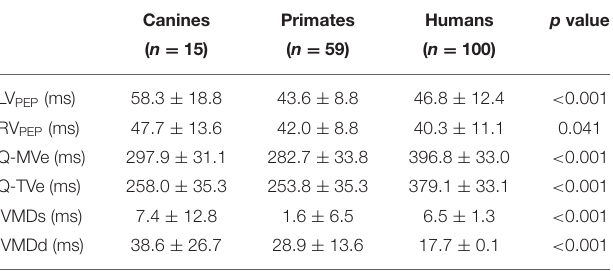
TABLE 2 | Species comparison of ventricular mechanical delays in healthy hearts.